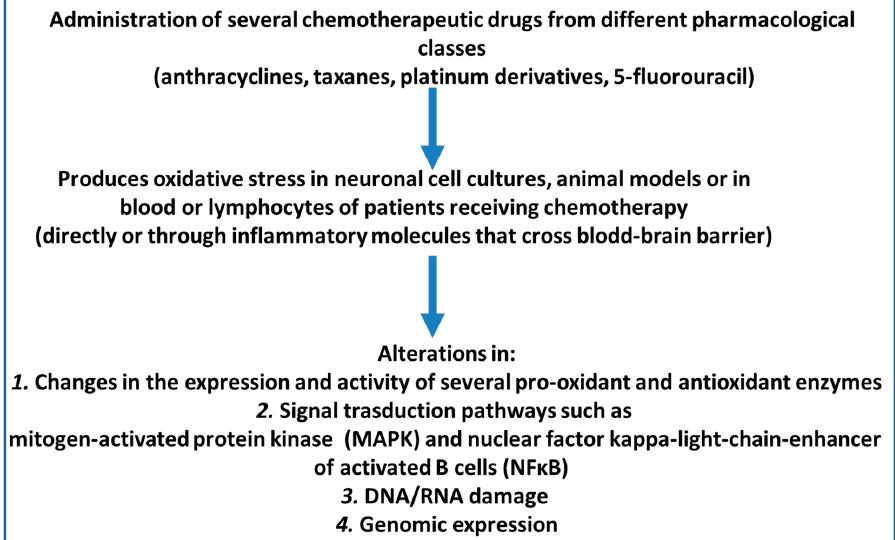
Figure 1. Oxidative stress mechanisms related to cognitive impairment after chemotherapy admin-